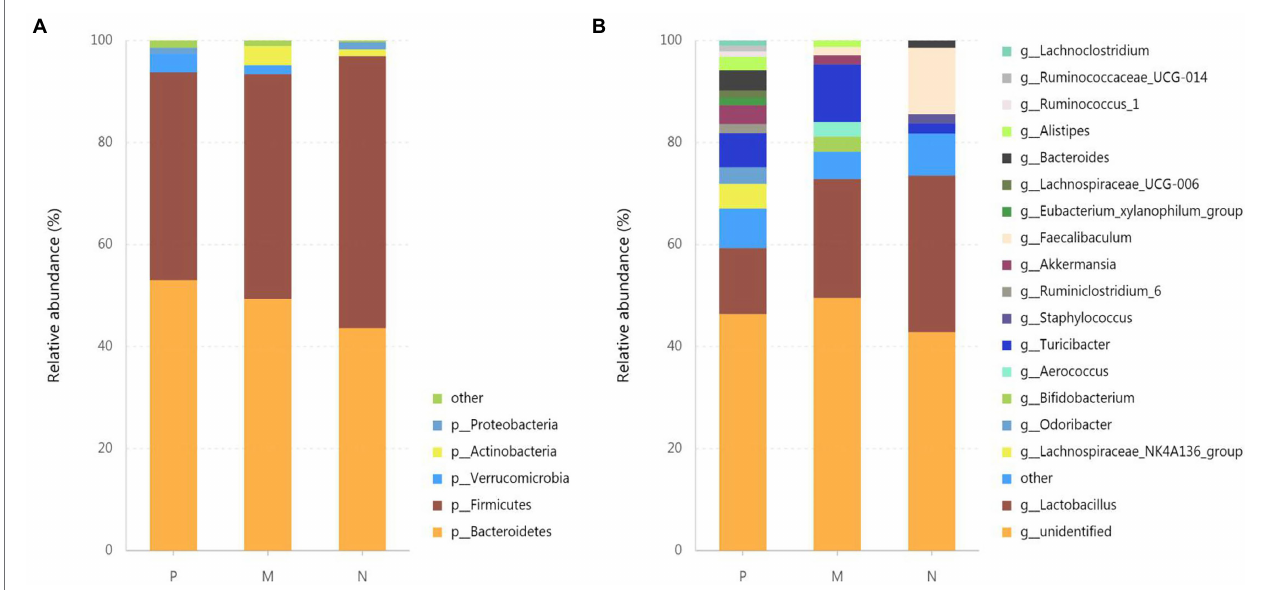
FIGURE 4 | Effect of L. plantarum 0111 on the gut microbial composition in mice infected with H9N2. Relative abundances of gut microbial groups at the phylum (A) and genus (B) levels. The relative abundances of gut bacteria presented here were calculated by averaging the data obtained from five replicates in each group. P, challenged H9N2 cells after pretreatment with PBS; M, challenged H9N2 cells after pretreatment with L. plantarum 0111; N, pretreatment with